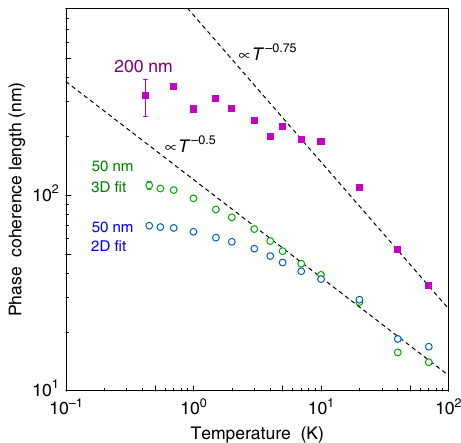
Fig. 6 Temperature dependence of phase coherence length in Sr 3 SnO obtained from localization analysis. Filled symbols represent data for a 200-nm-thick fi lm analyzed by the 3D localization formula, whereas open symbols represent those for a 50-nm-thick fi lm analyzed by the 3D formula and 2D formula (HLN formula). Error bars are estimated at the lowest temperature for each data using standard deviation. For the 50-nm fi lm, the error was comparable or smaller than the size of the open symbols. Theory predicts dephasing from electron – electron interaction to follow l ϕ = T − 0.75 in 3D systems (upper dashed line), while l ϕ = T − 0.5 in 2D systems (lower dashed line). Source Data are provided as a Source Data fi